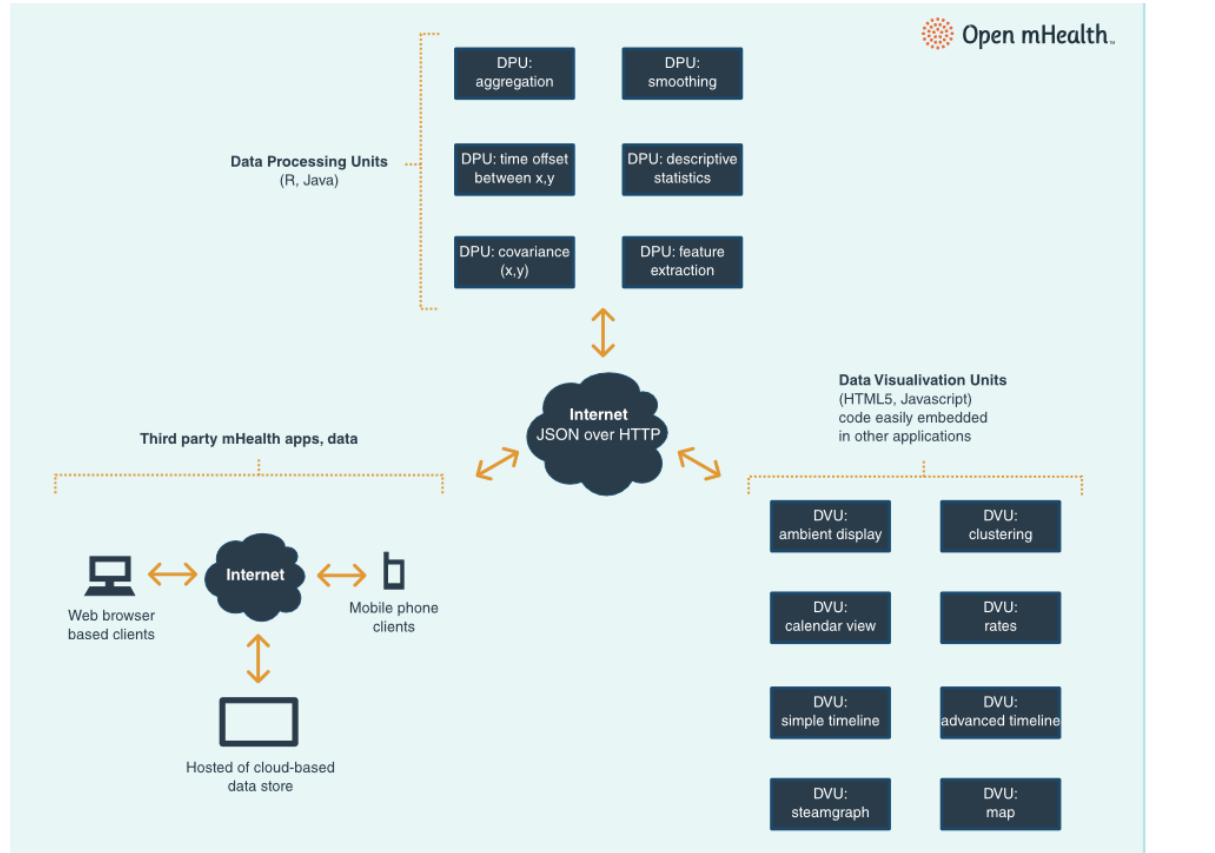
Figure 2. InfoVis: Third-party data applications and data stores save and manage data. Data processing units (DPUs) are the building blocks for extracting relevant features and patterns from data streams. Data visualization units enable visual presentations to be created from the extracted data features. Each DPU and DVU completes one task, and then can be composed for higher functions. HTTP = hypertext transfer protocol, JSON = JavaScript object